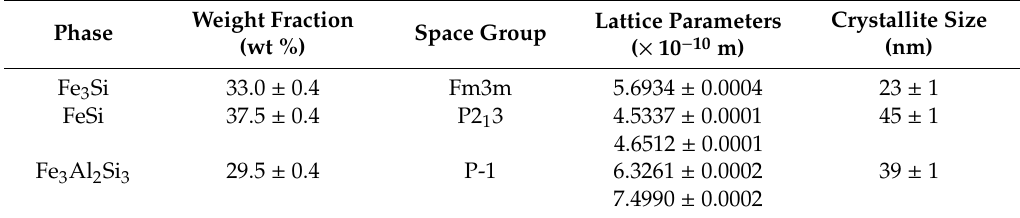
Table 2. Weight fraction, lattice parameters, and crystallite size of individual phases in FeAl20Si20 alloy (determined by Rietveld refinement of XRD